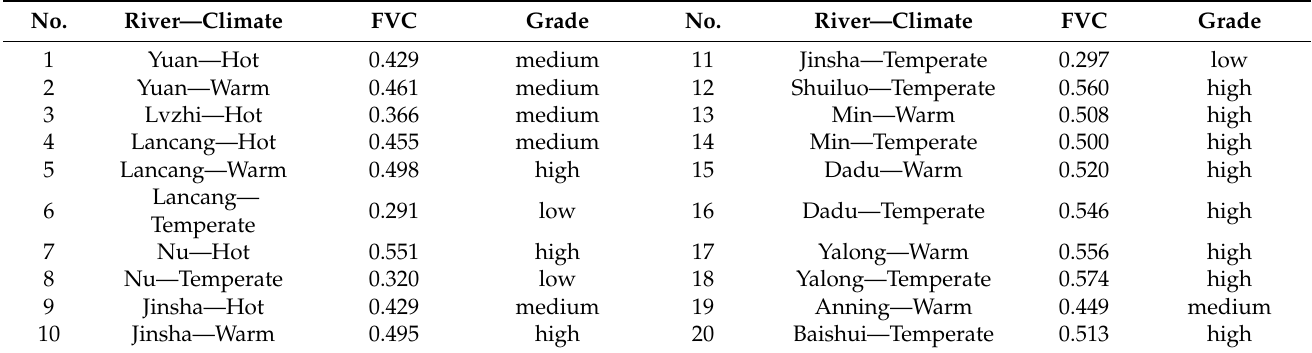
Table 4. The long-term average annual FVC of 20 dry valleys in Southwest